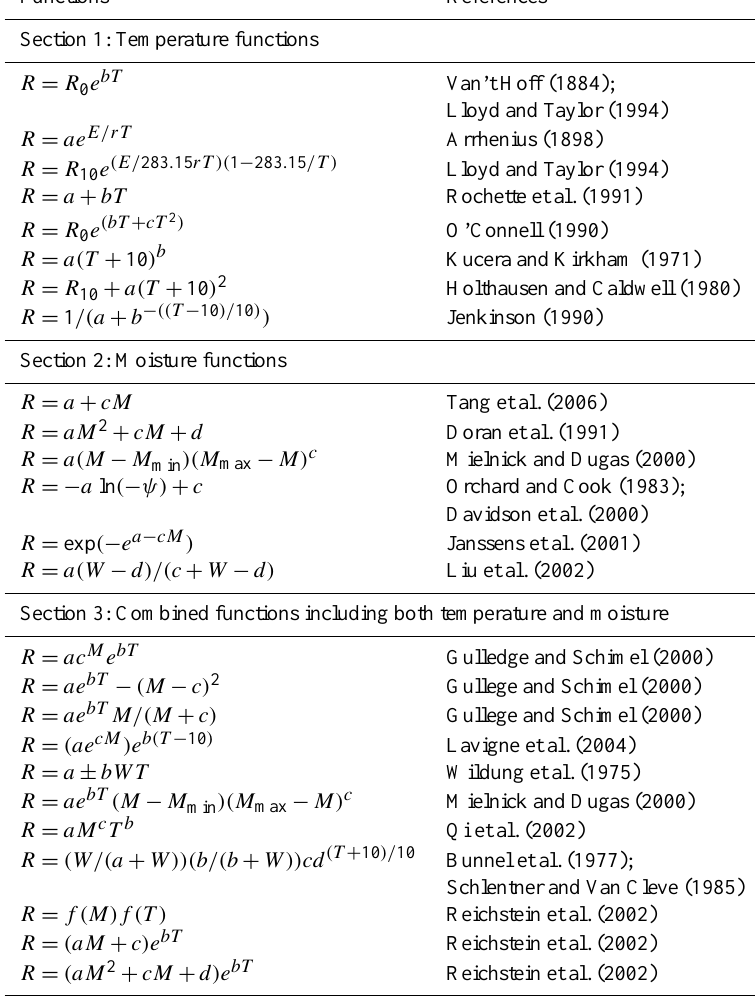
Table 1. Review of soil respiration models with soil temperature and